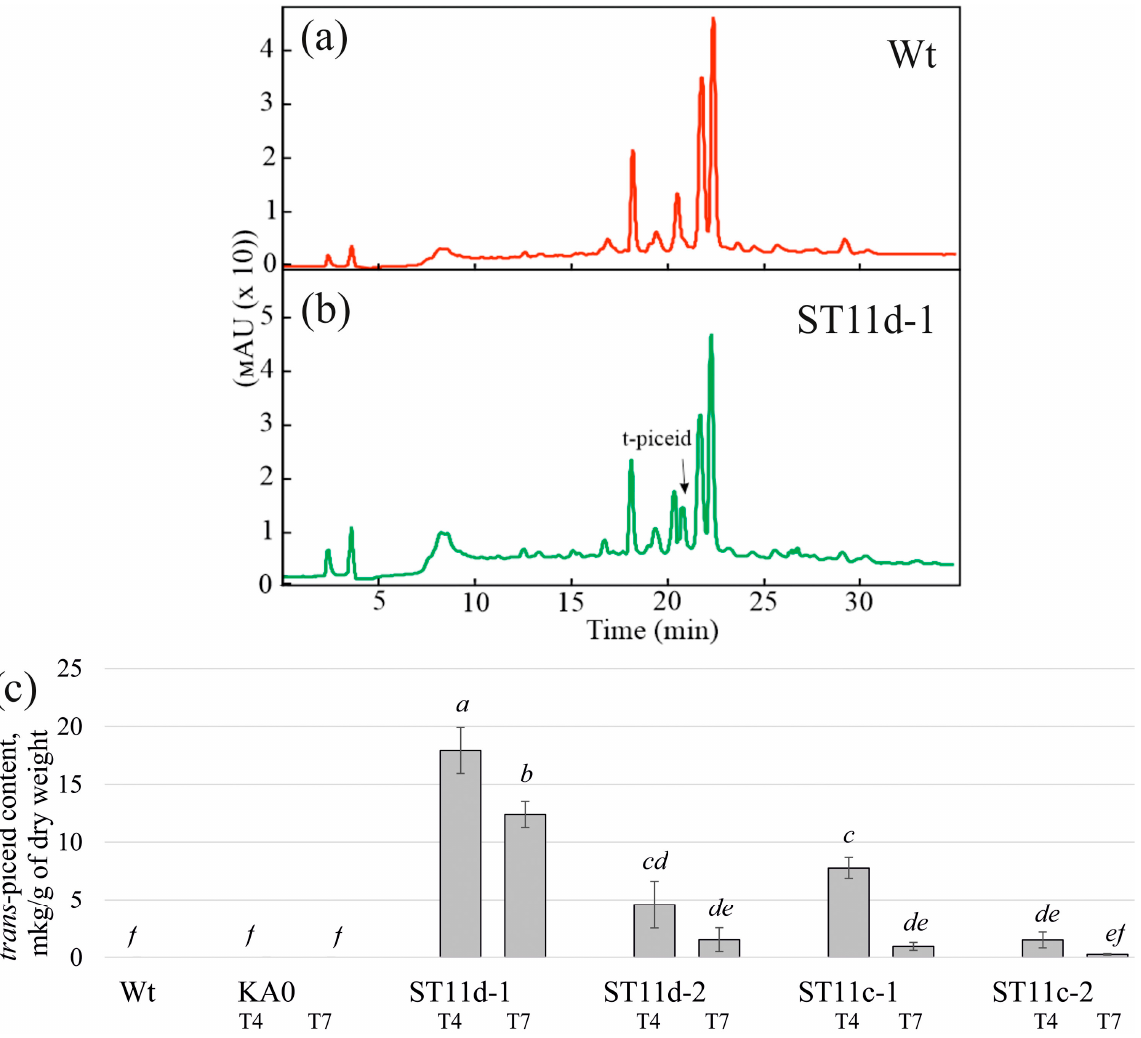
Figure 2. HPLC detection ( a , b ) and quanti fi cation ( c ) of the trans -piceid content in the VaSTS11d and VaSTS11c transgenic Arabidopsis thaliana . Wt—wild-type A. thaliana plants; KA0—the control KA0 A. thaliana plants transformed with the vector harboring only the npt II selective marker; ST11d-1, ST11d-2—two A. thaliana plant lines transformed with the VaSTS11d gene; ST11c-1, ST11c-2—two A. thaliana plant lines transformed with the VaSTS11c gene; T 4 and T 7 — VaSTS11d and VaSTS11c expression in transgenic A. thaliana of the T 4 and T 7 generations. The data are presented as mean ± SE (two independent experiments with eight technical replicates). Means followed by the same letter were not di ff erent using Student’s t test, where p < 0.05 was considered to be statistically signi fi cant.